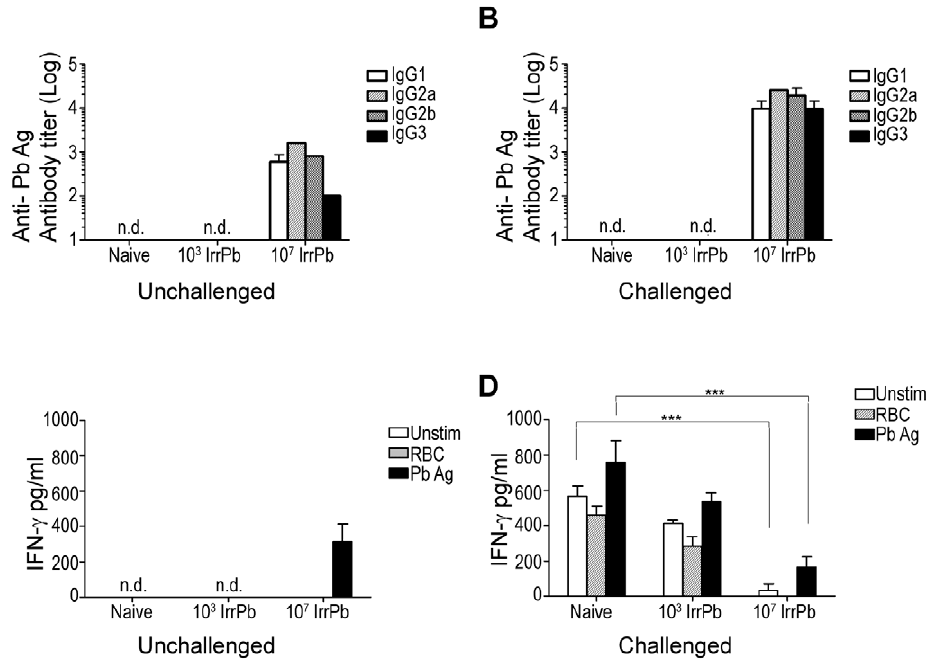
Figure 4. Immune responses associated with IrrPb immunization in C57BL/6 mice. C57BL/6 mice were immunized once with 10 3 or 10 7 IrrPb, challenged with virulent pRBC, and tissues were harvested on day 6 when ECM appeared in naı¨ve mice. A and B ) Serum IgG antibodies (subclasses IgG1, IgG2a, IgG2b, and IgG3) to blood-stage Pb-A antigen were measured by endpoint ELISA. Values are averaged from two independent experiments. Parasite-specific IgG antibodies were not detected (n.d.) in sera from naı¨ve mice or 10 3 IrrPb immunized mice before (A) or